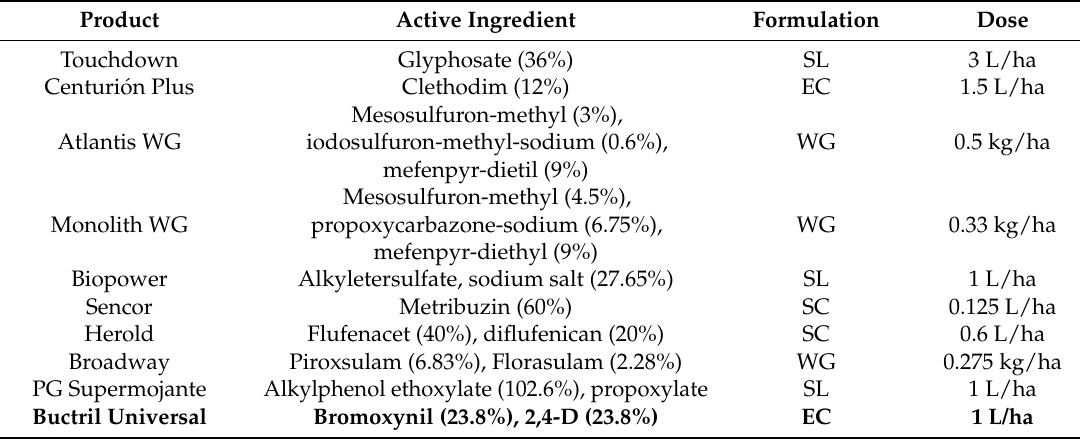
Table 2. Applied herbicides during the three growing